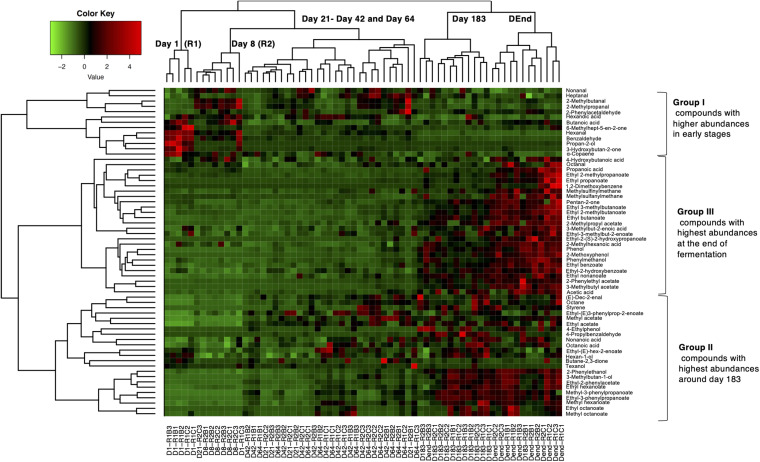
Normalized heat-map representation of volatile abundance changes during Nyons table olive fermentations. Hierarchical clustering was performed using Ward’s Linkage and Euclidean distance. Sample names are at the bottom whereas compounds are on the right part of the map. Color ranging from red to green indicates low to high abundances.